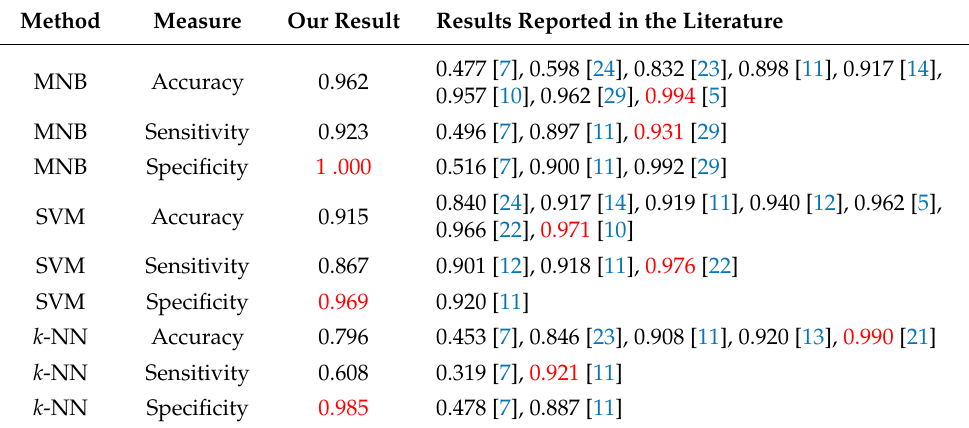
Table 18. Comparison of the validation results with various performance